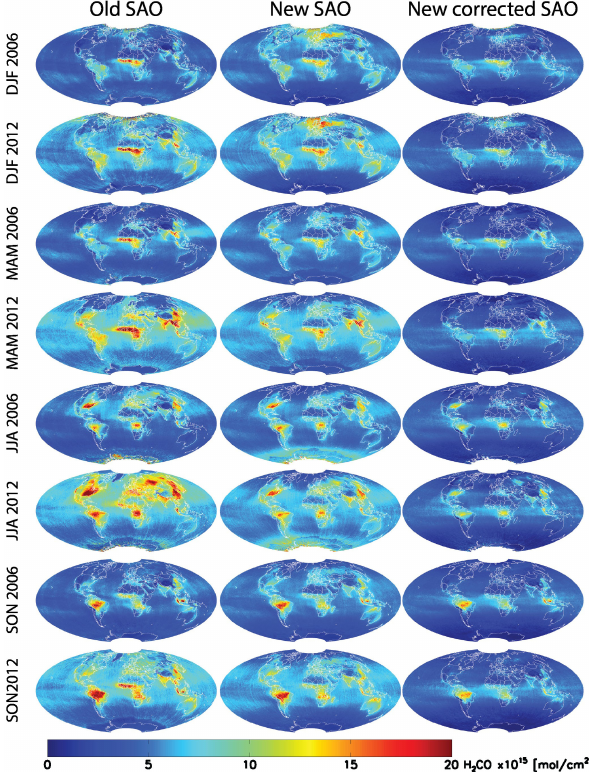
Figure 11. Seasonal averages for 2006 and 2012. Left column shows the old SAO retrieval, middle column shows the new retrieval without the reference sector correction, and right column shows new retrieval with the reference sector